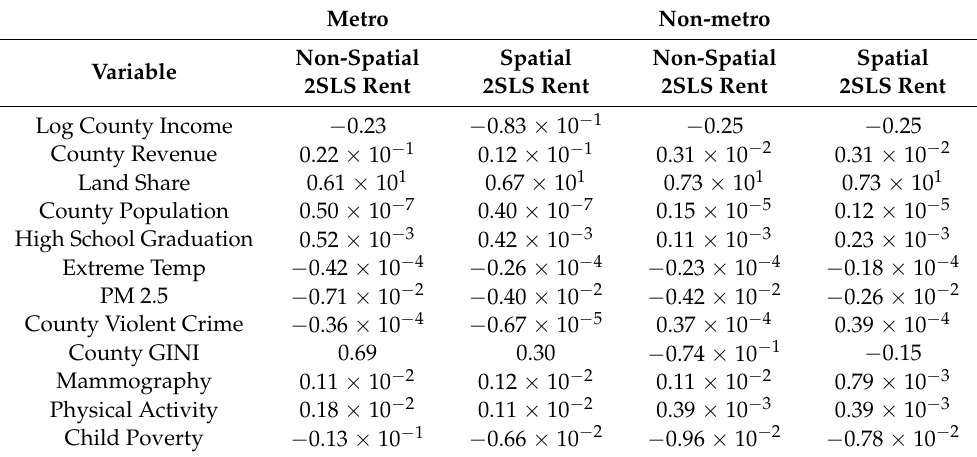
Table 1. Direct marginal effects for rent equations: non-spatial versus spatial models in the continental United States.